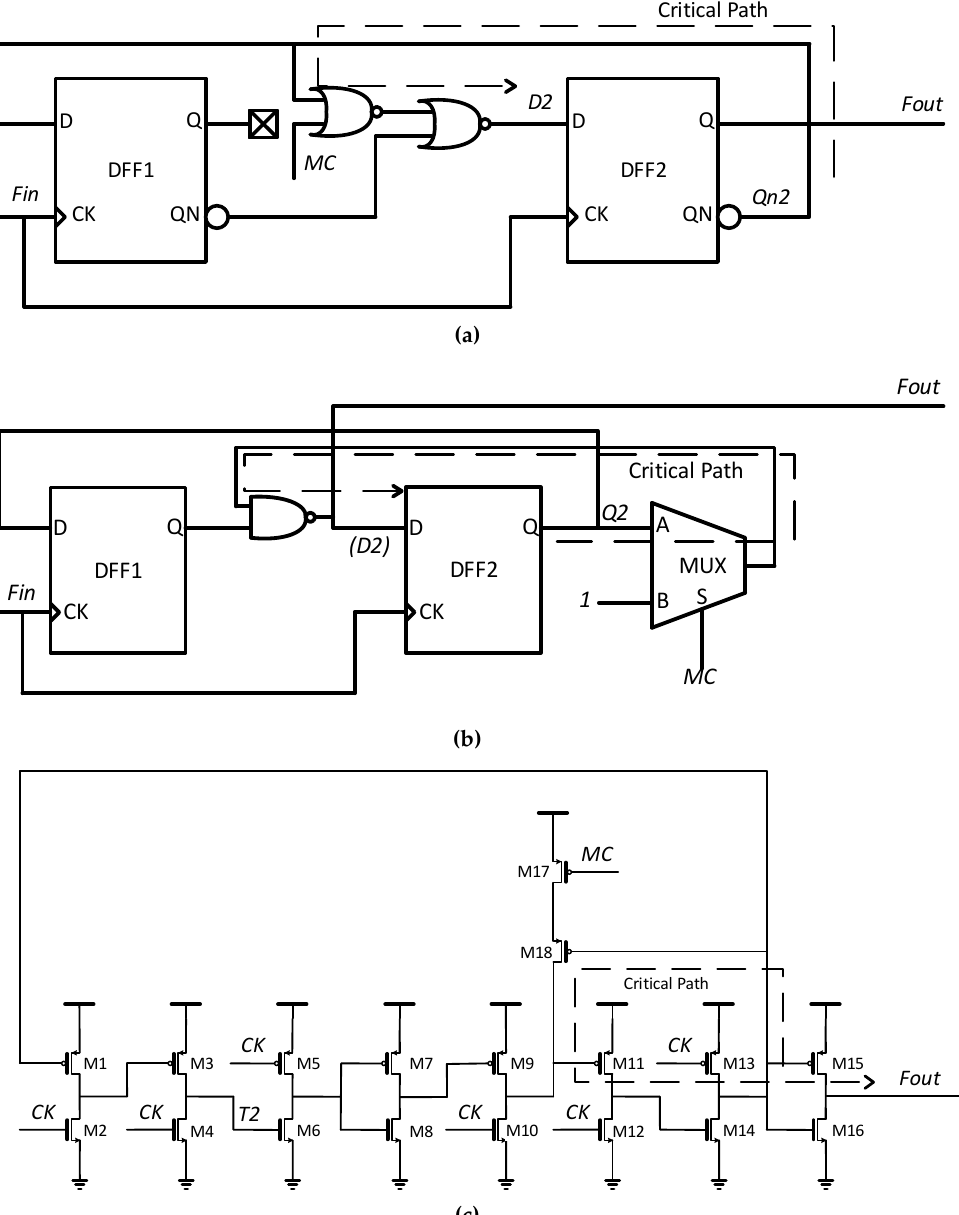
Figure 2. Conventional divide-by-3/4 divider prescalers ( a ) not-or(NOR)-based prescaler; ( b ) multiplex(MUX)-based prescaler; ( c ) prescaler presented in Reference